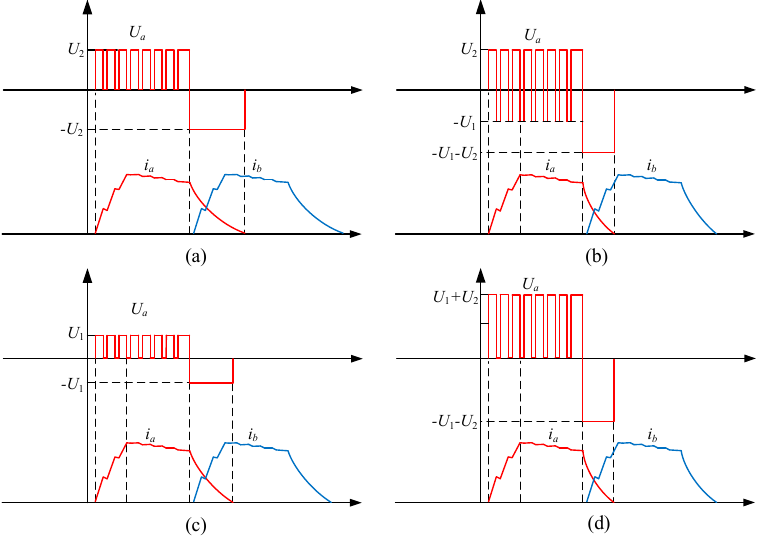
Figure 6. Phase voltage and current waveforms with the SRM driven by ( a ) the conventional converter, ( b ) the PV panel, ( c ) the battery bank, and ( d ) the dual-source. ( b ) the PV panel, ( c ) the battery bank, and ( d ) the dual-source. Mode 2: Driven by the battery